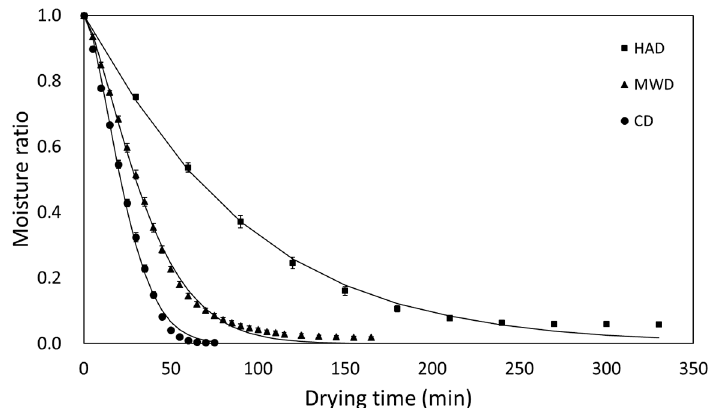
Figure 4. Drying curves of radish slabs undergoing different drying methods (hot-air drying (HAD), microwave drying (MD), and hot-air and microwave combination drying (HMCD)).